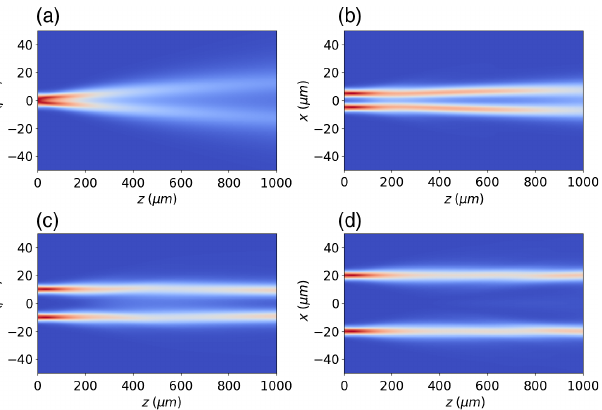
FIG. 6. Simulations of the two-beam interaction. Overall intensity distribution calculated on the plane xz when the initial distance is (a) 4 μ m, (b) 10 μ m, (c) 20 μ m, and (d) 40 μ m. The two beams are both circularly polarized but with inverted spin. The input waist is 4 μ m, the wavelength is 1064 nm, the cell length along z is 1 mm, and the input power is P ¼ 8 mW on each